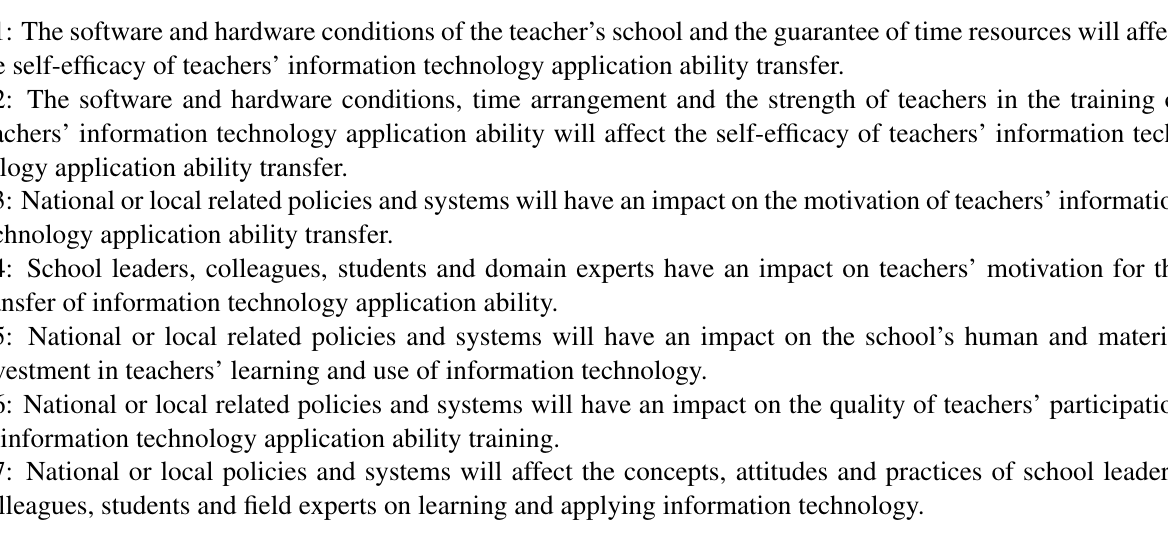
Fig. 1 Schematic diagram of conditional assumption